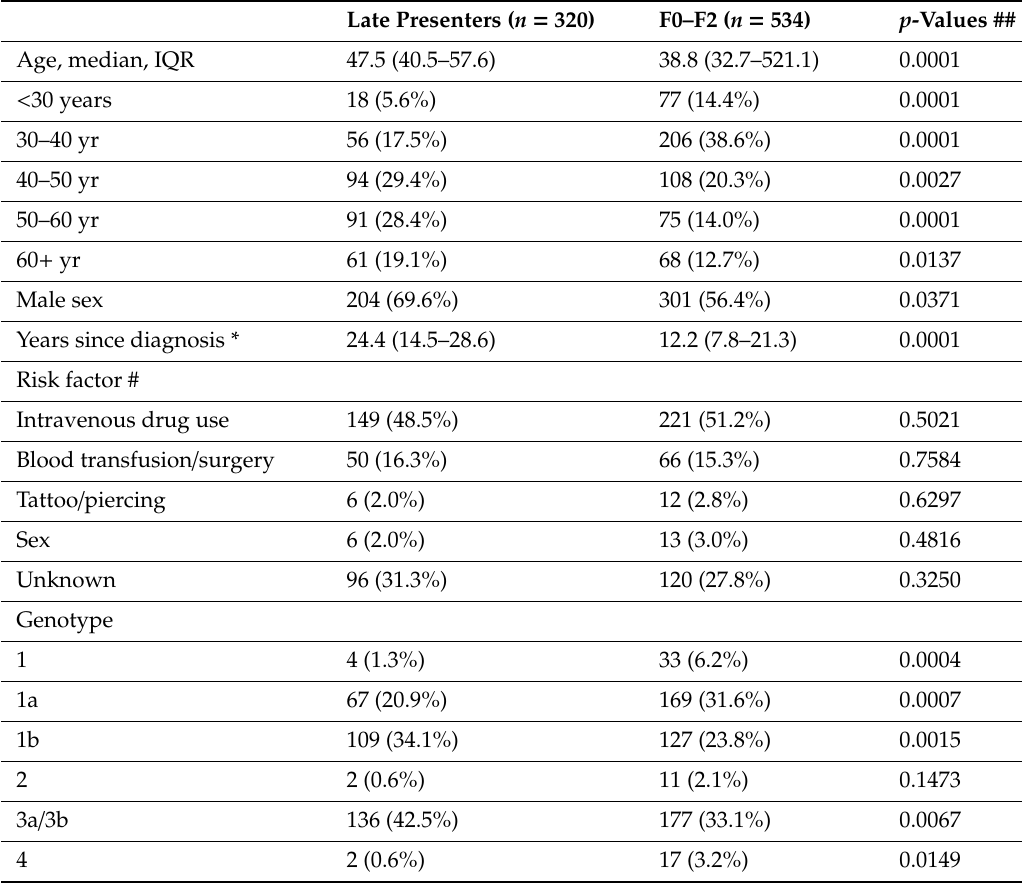
Table 1. Baseline patients’